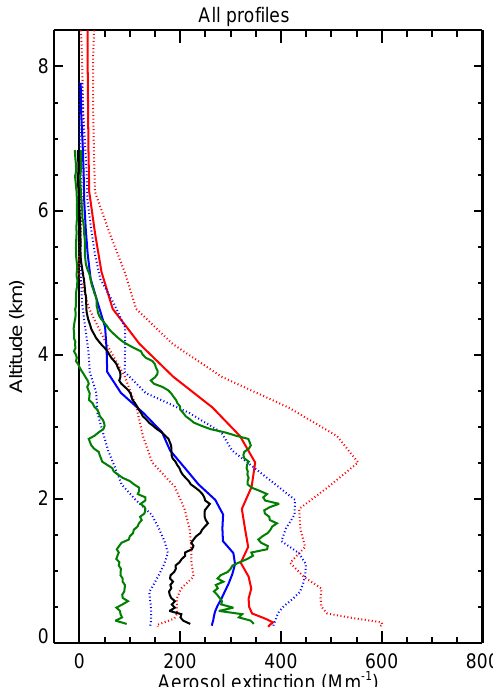
Figure 9. Lidar summary vertical profile resulting from all the 276 lidar profiles (black), together with the curves representing ± 1 standard deviation (green). The MetUM (blue) and ECMWF- MACC (red) mean vertical profiles and their standard deviation are also shown for the same collection of flight